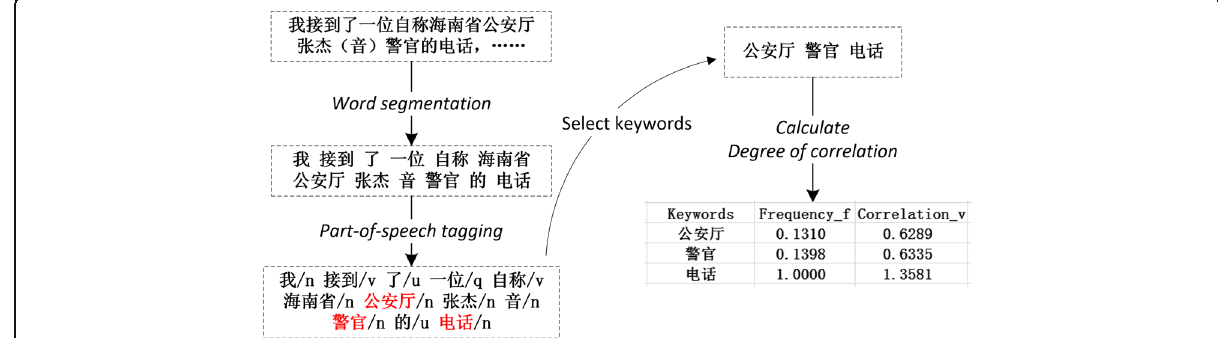
Fig. 2 Example of extraction features